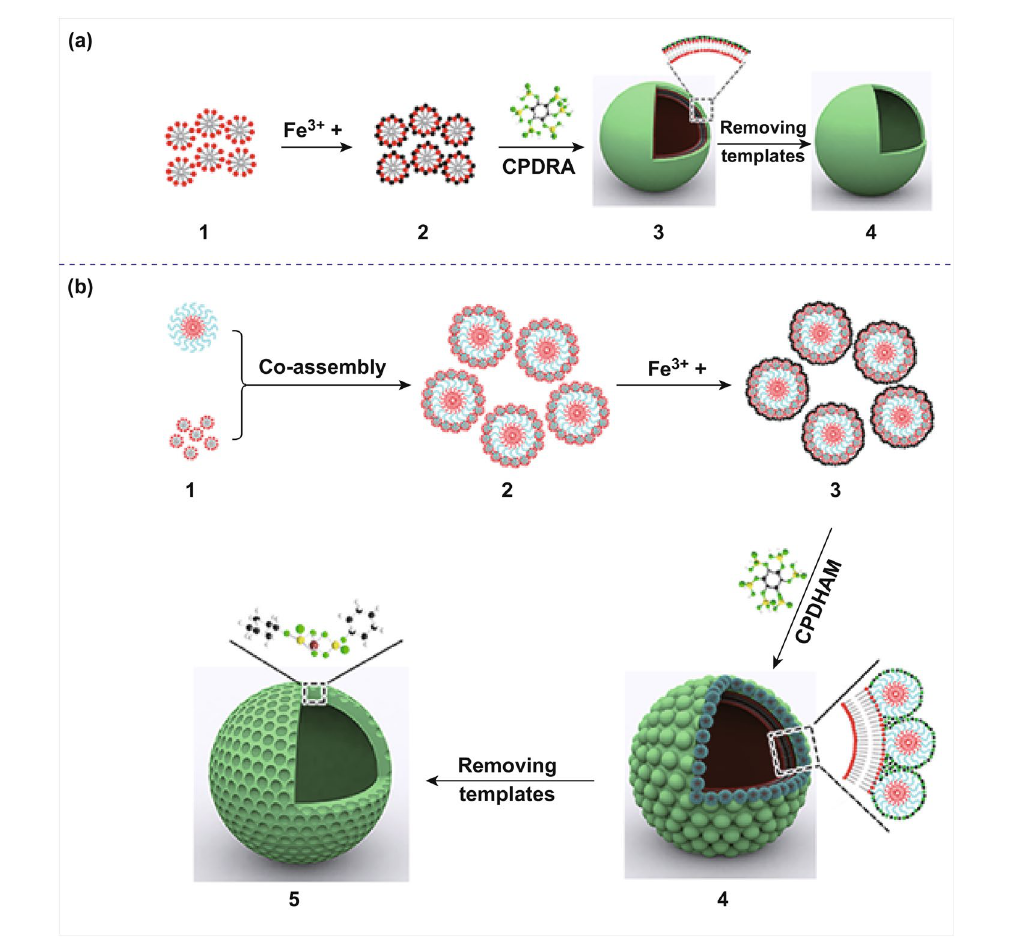
Fig. 4 Scheme of the synthesis of hollow FePA nanospheres ( a ) and mFePA-HS ( b ). a : (1) The spherical micelles assembled by PFOA. (2) Fer- ric ions were absorbed on the surface of PFOA micelles due to electrostatic interaction. (3) The formation of pristine ferric phytic acid hollow sphere with the addition of phytic acid by the method of coordination polymerization-driven reassembly (CPDRA) of PFOA micelles. (4) The resultant ferric phytic acid hollow sphere. b : (1) The preformed spherical micelles of BCP and PFOA. (2) Hierarchical co-assembly of PFOA and BCP micelles. (3) Ferric ions were absorbed on the surface of PFOA@BCP. (4) The formation of pristine mesoporous ferric phytate hollow sphere with the addition of phytic acid by coordination polymerization-driven hierarchical assembly of micelles (CPDHAM). (5) The obtained mesoporous ferric phytate hollow sphere after the template